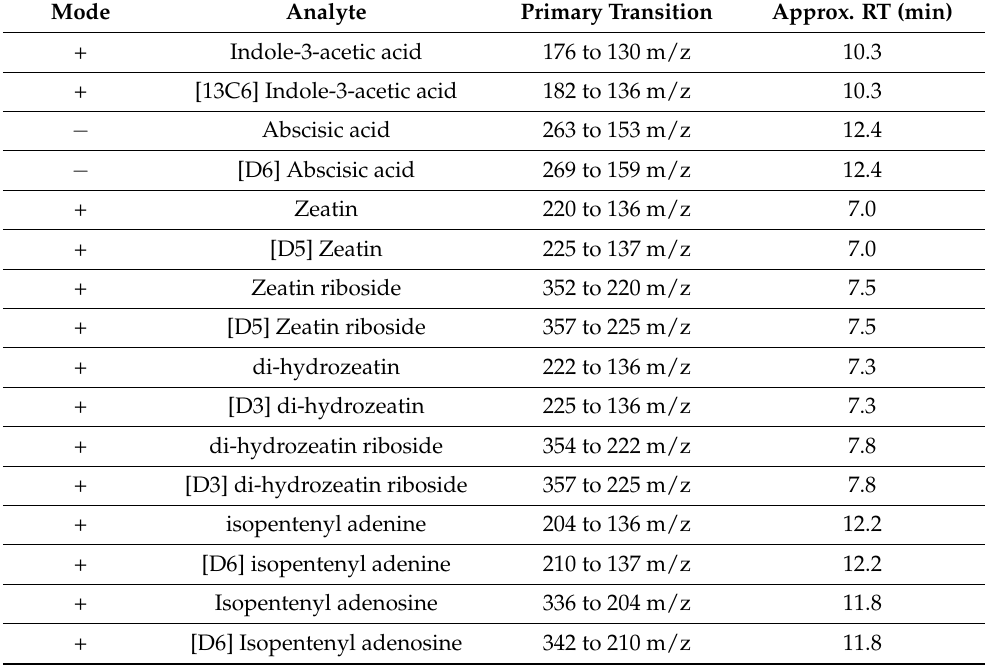
Table A1. MRM transitions monitored to identify and quantify endogenous hormones and labelled standards from cherry bud